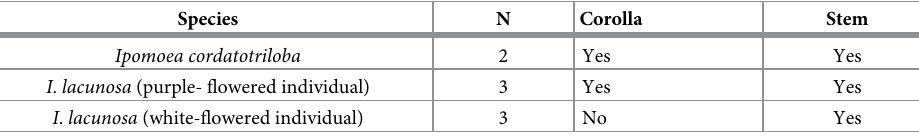
Table 1. Presence vs. absence of anthocyanins in different tissues for different species/flower color combinations. Species N Corolla Stem Ipomoea cordatotriloba 2 Yes Yes 3 Yes Yes I . lacunosa (white-flowered individual) 3 No Yes “Yes” indicates anthocyanidins detected. “No” means not